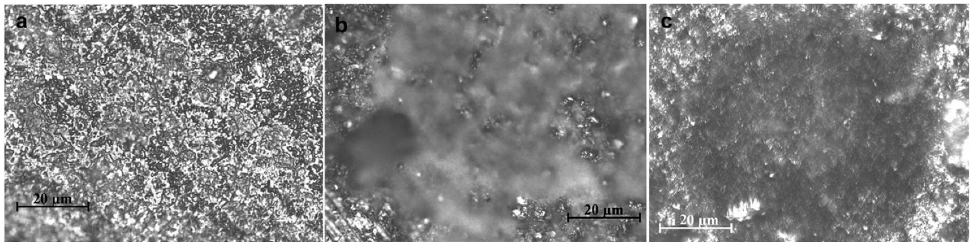
Figure 13. Optical micrographs of a steel plate, which is cooled by ( a ) water, ( b ) TiO 2 + water, ( c ) MWCT + water. Adapted from [178], Copyright (2012), with permission from